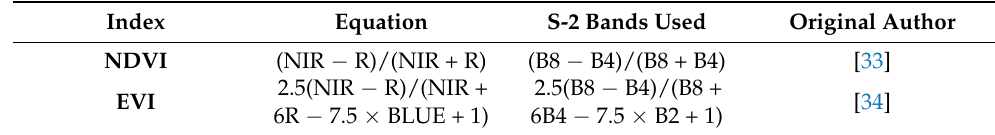
Figure 4. Flowchart of the proposed method for producing crop mapping using machine learning based on five experiments and two scenarios. Table 4. Vegetation Indices and their expressions used in this